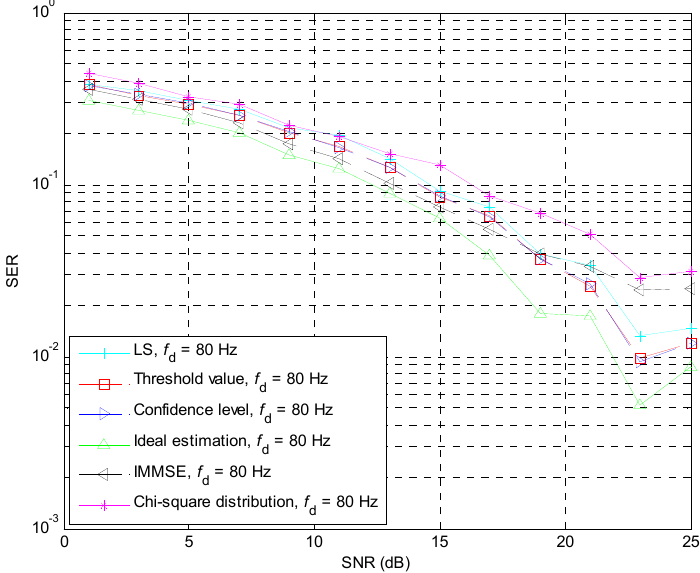
Figure 10. SER performance of the 16 QAM-modulated CP-OFDM system over Brazil D under =